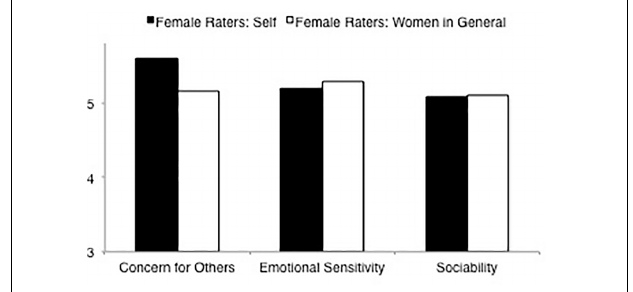
FIGURE 7 | Ratings of communality dimensions (concern for others, emotional sensitivity, sociability) by female raters rating self and women in